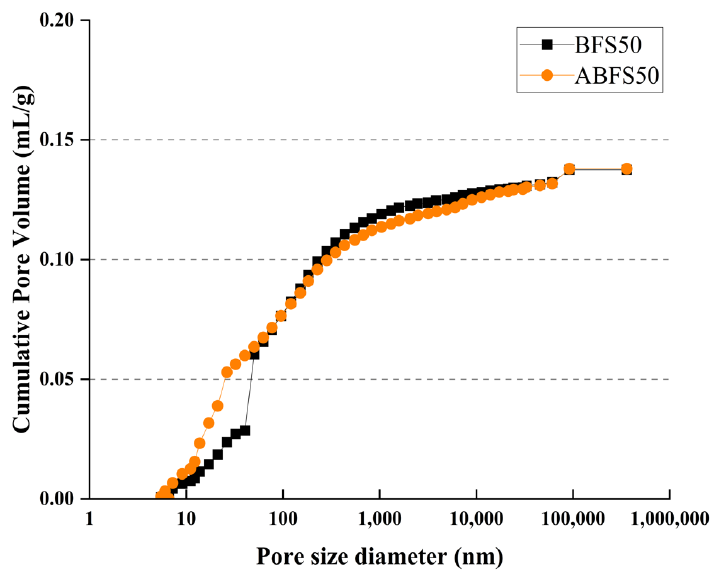
Figure 18. Porosity results for BFS50 and